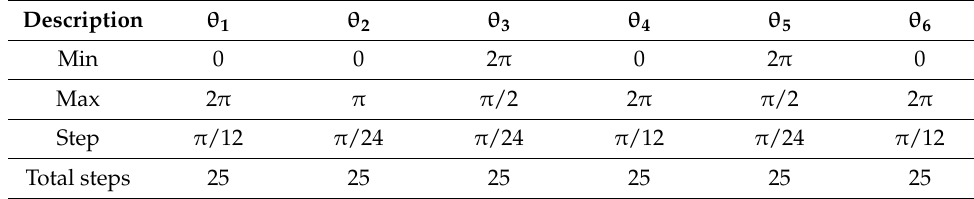
Table 2. Range of motion and step size at each of the